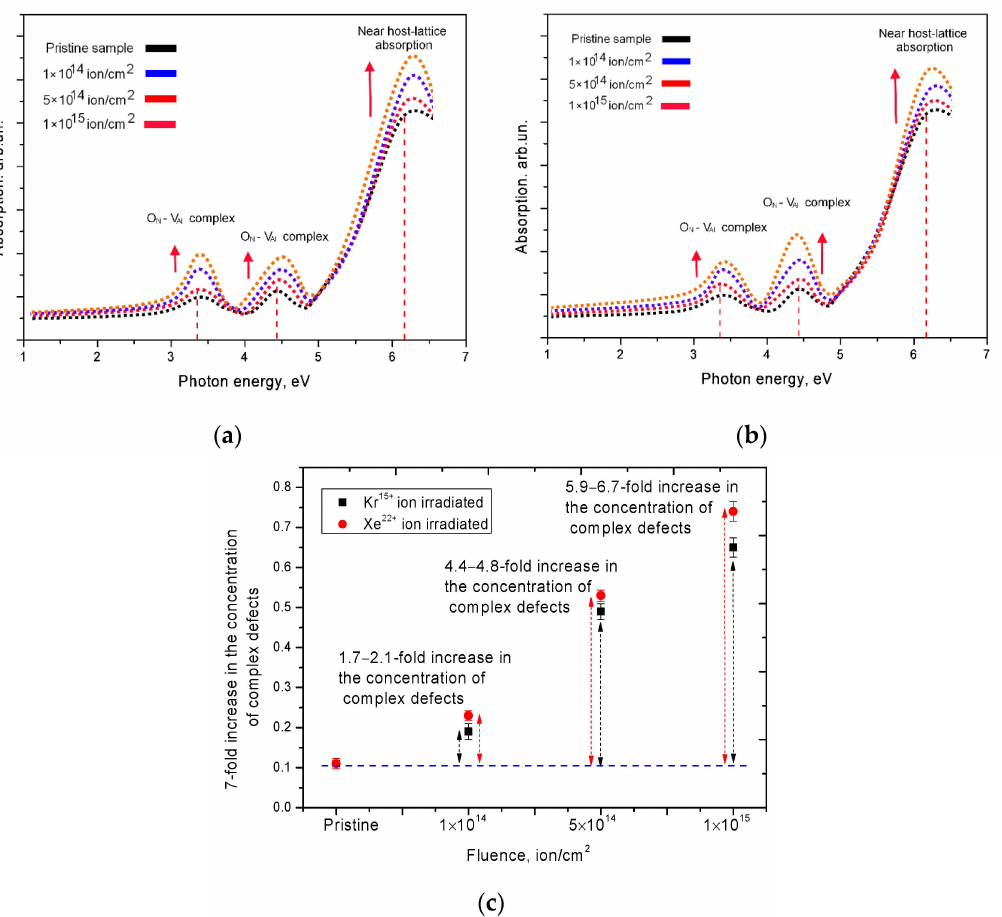
Figure 8. UV-Vis absorption spectra of ceramics before and after irradiation: ( a ) Kr 15 + ion irradiated dose; ( b ) Xe 22 + ion irradiated dose; ( c ) Semi-quantitative analysis of the concentration of complex defects depending on the type of